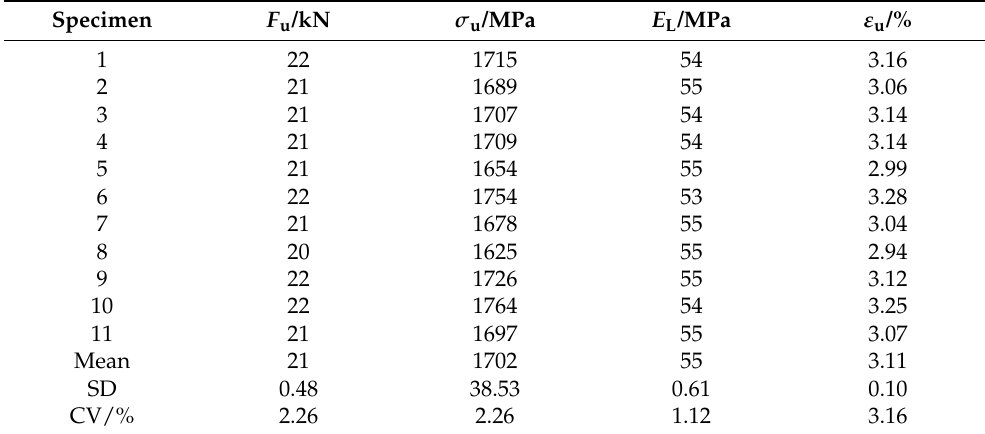
Table 1. Testing results for the BFRP tendons.